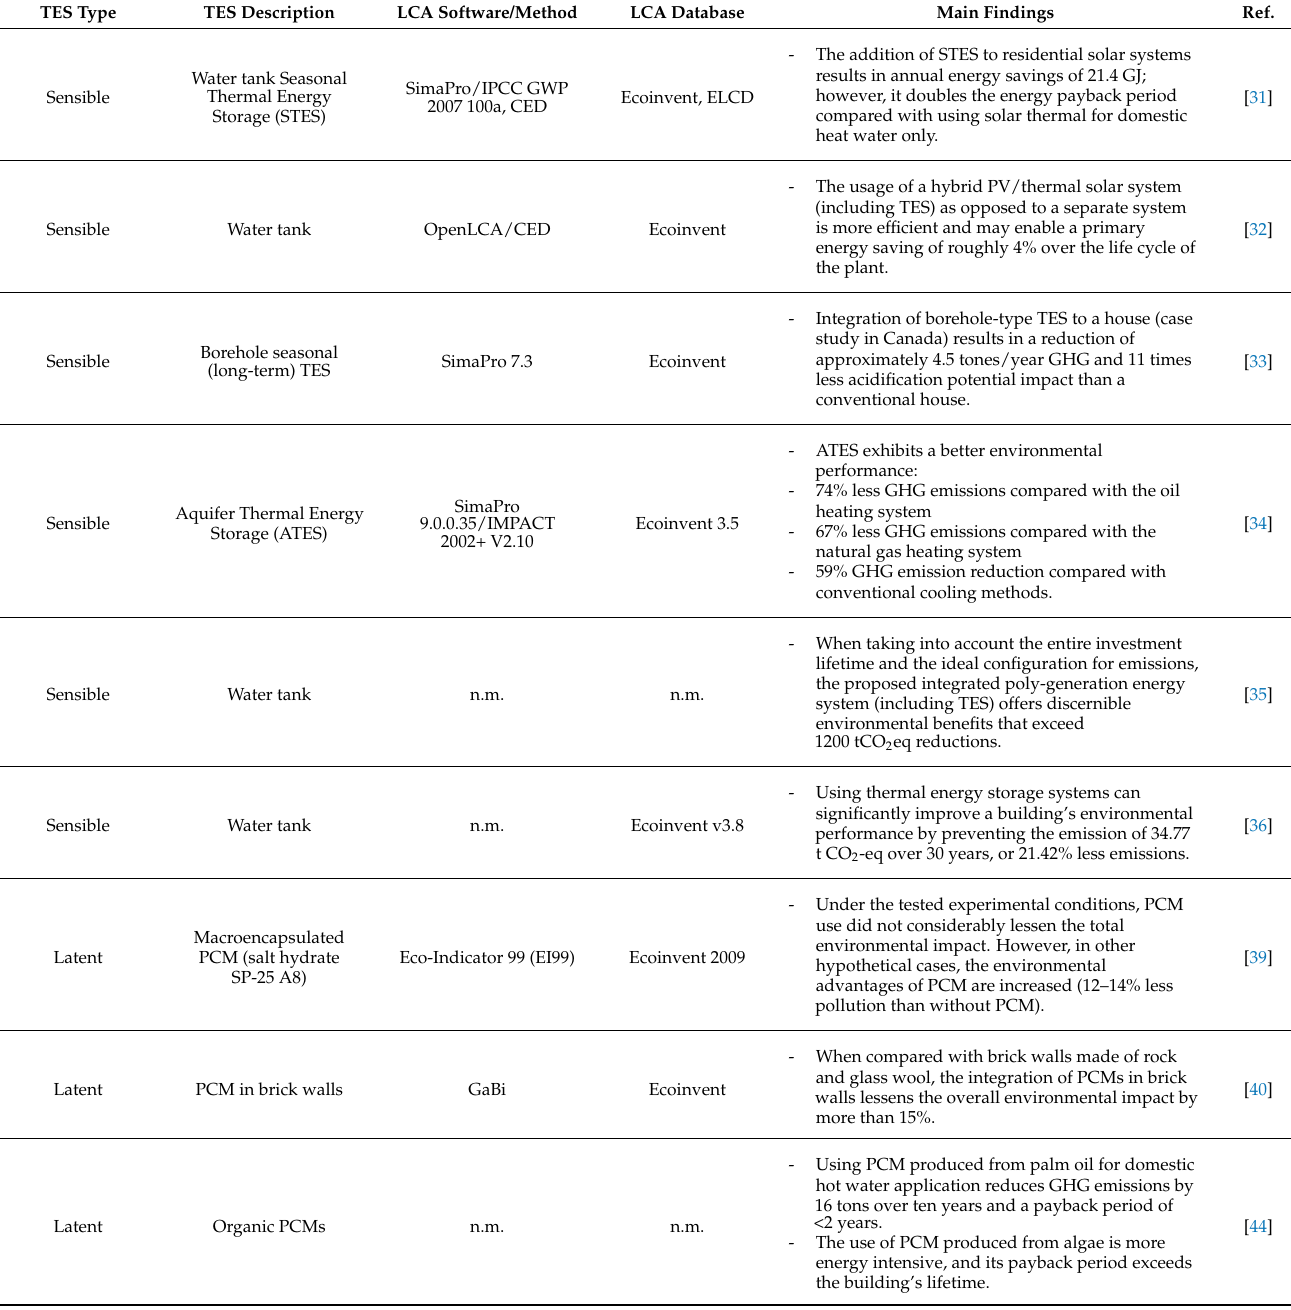
Table 4. LCA studies of TES for building